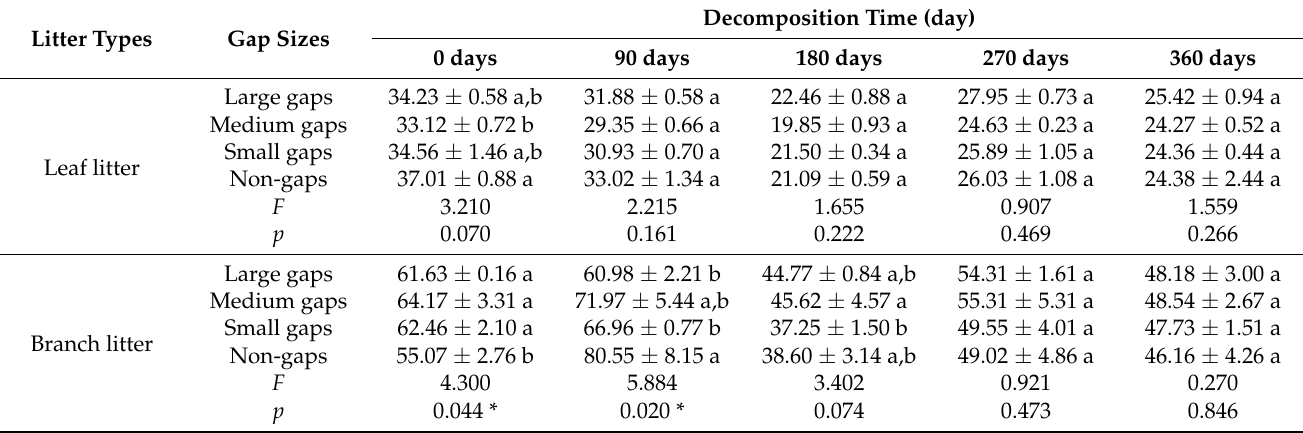
Table A6. C/N ratio of litter in canopy gaps and